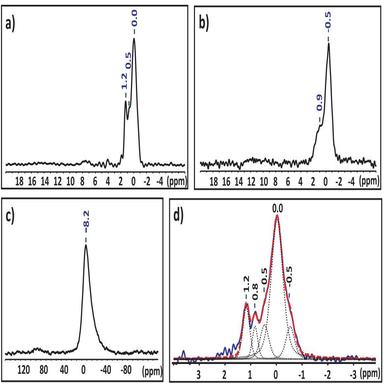
1D MAS NMR spectra of Hu-dentin: 1D 1H/43Ca (a) and 1H/23Na (b) D-HMQC (νr = 12 kHz), (c) 1D 23Na (νr = 12 kHz, relaxation delay 1s), (d) 1H DF-SE (νr = 60 kHz) with very long 23 ms filtering time (in blue) with spectral deconvolution (in red).